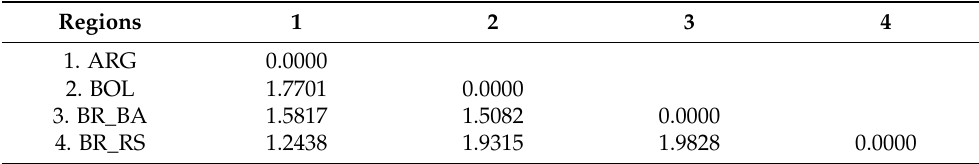
Table 3. Mahalanobis distances between populations of T. infestans from different regions.